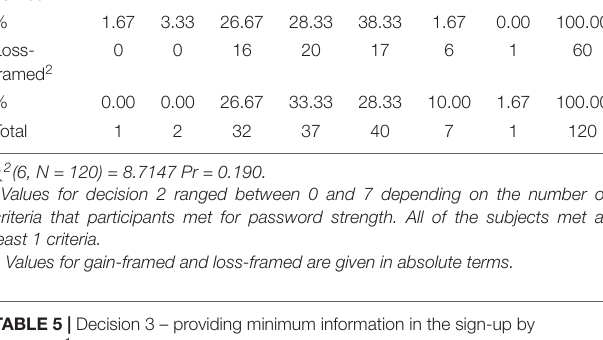
TABLE 5 | Decision 3 – providing minimum information in the sign-up by treatment 1 . Treatment